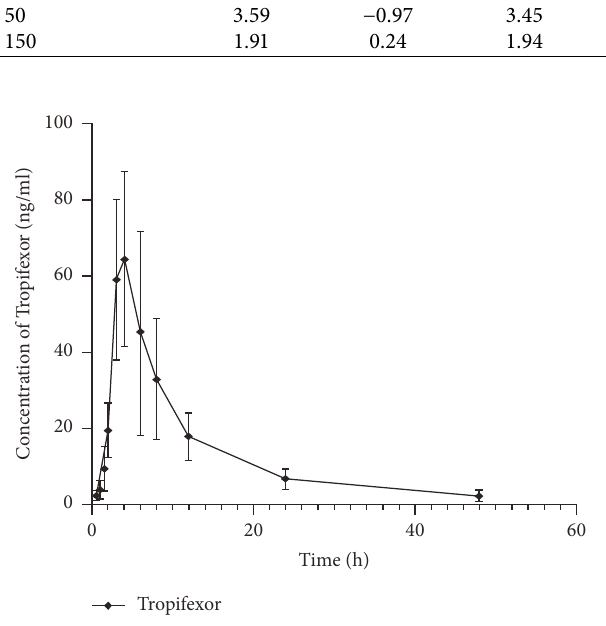
Figure 3: Mean plasma concentration–time curves of tropifexor in beagles ( n � 6). Table 5: The major pharmacokinetic parameters ascribed to tro- pifexor in beagles ( n � 6, Mean ± SD).